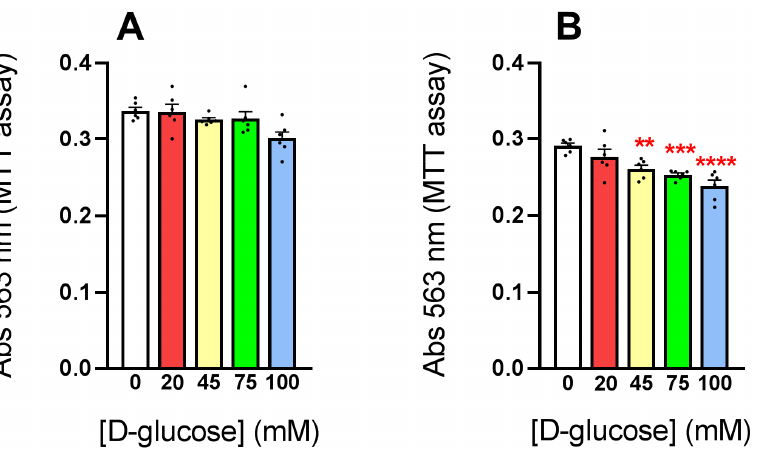
Figure 1. Effect of high glucose exposure on HLE cells’ viability. HLE cells were grown as described in Section 2.2 and maintained for 24 h ( A ) and 48 h ( B ) in MEM supplemented with the indicated D-glucose concentrations. Cell viability was evaluated as described in Section 2.3. All values are reported as the mean ± SEM of six independent measurements. Statistical analysis was performed using one-way ANOVA with Tukey post hoc test. Significance was evaluated with respect to cells